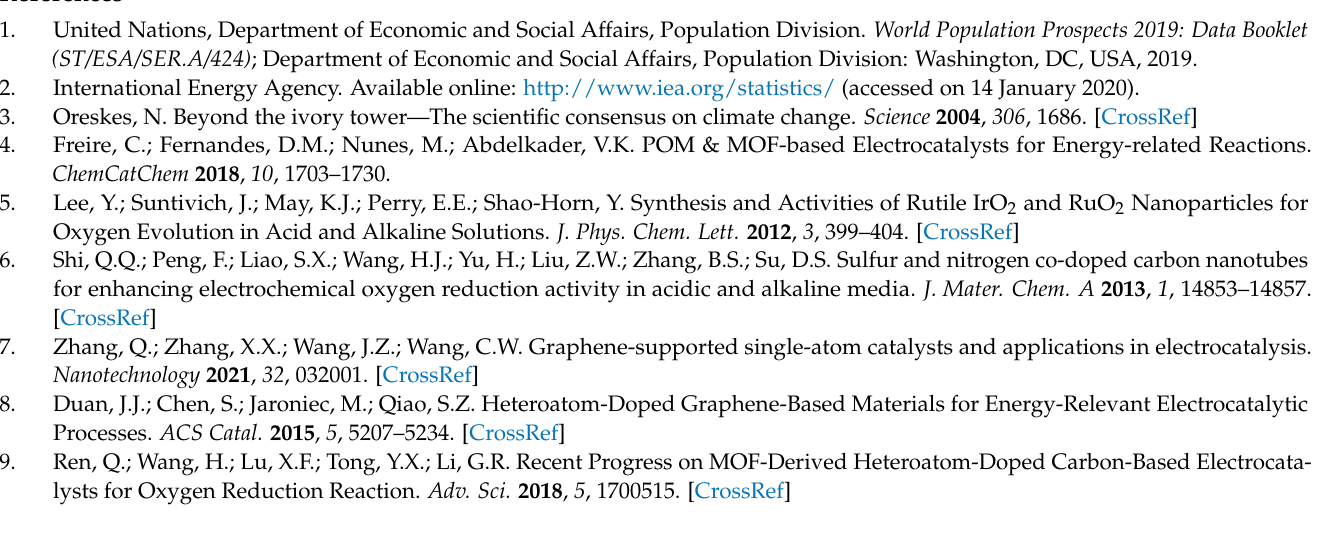
Table S3. Onset potentials ( E onset ), diffusion-limiting current density ( j L ) and the number of